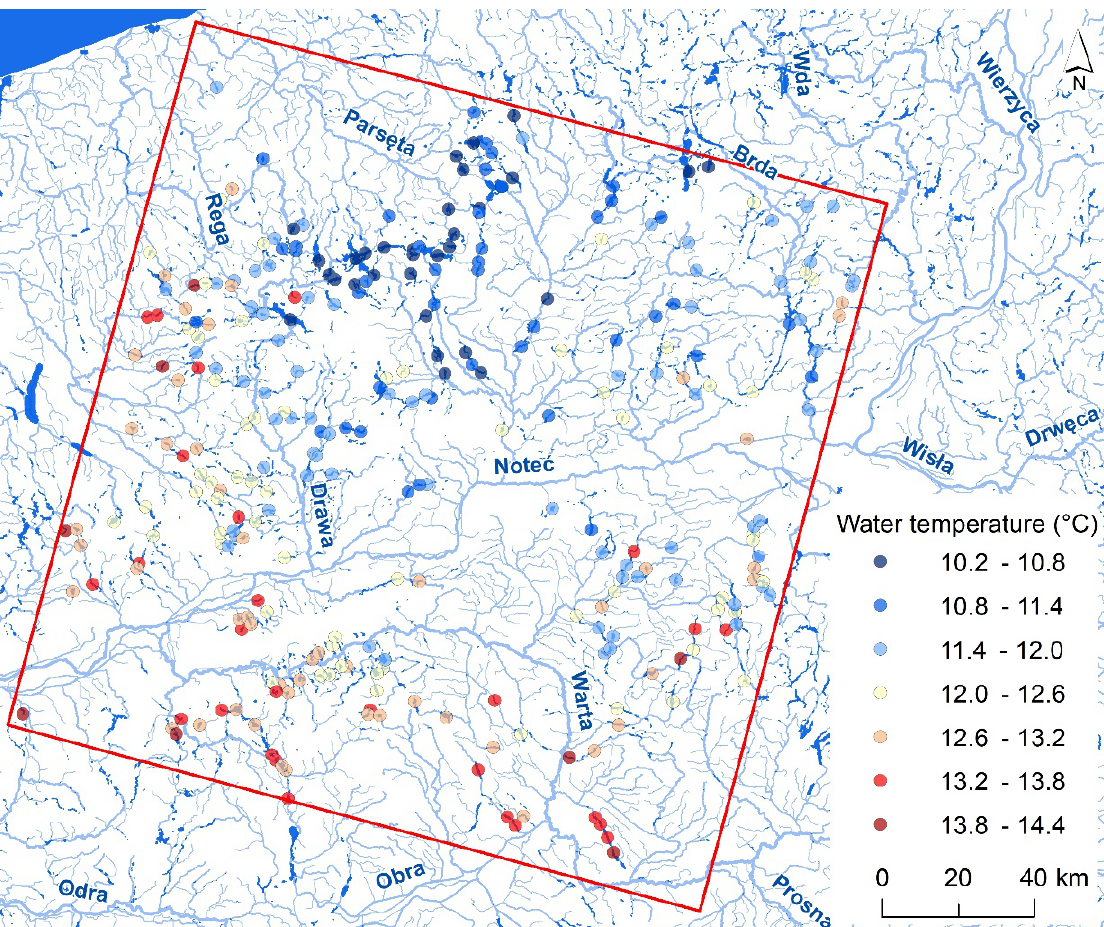
Figure 10. Median surface temperatures of non-monitored lakes as of 28 April 2021.